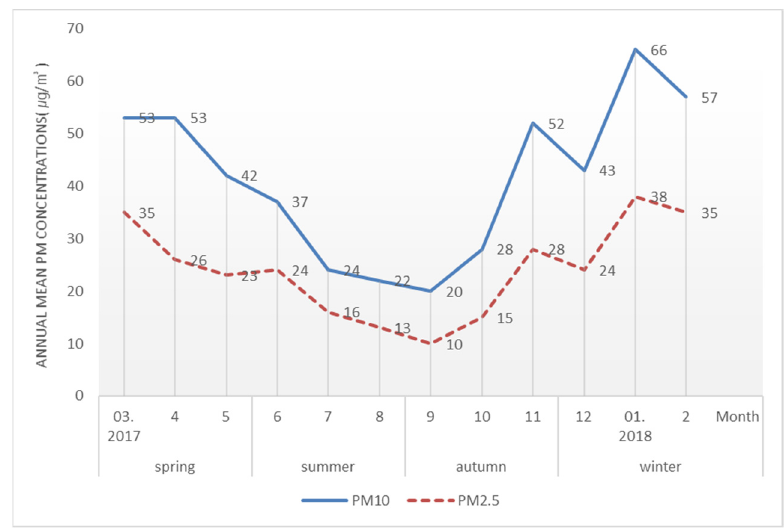
Figure 3. Seasonal dust concentrations in Seoul.